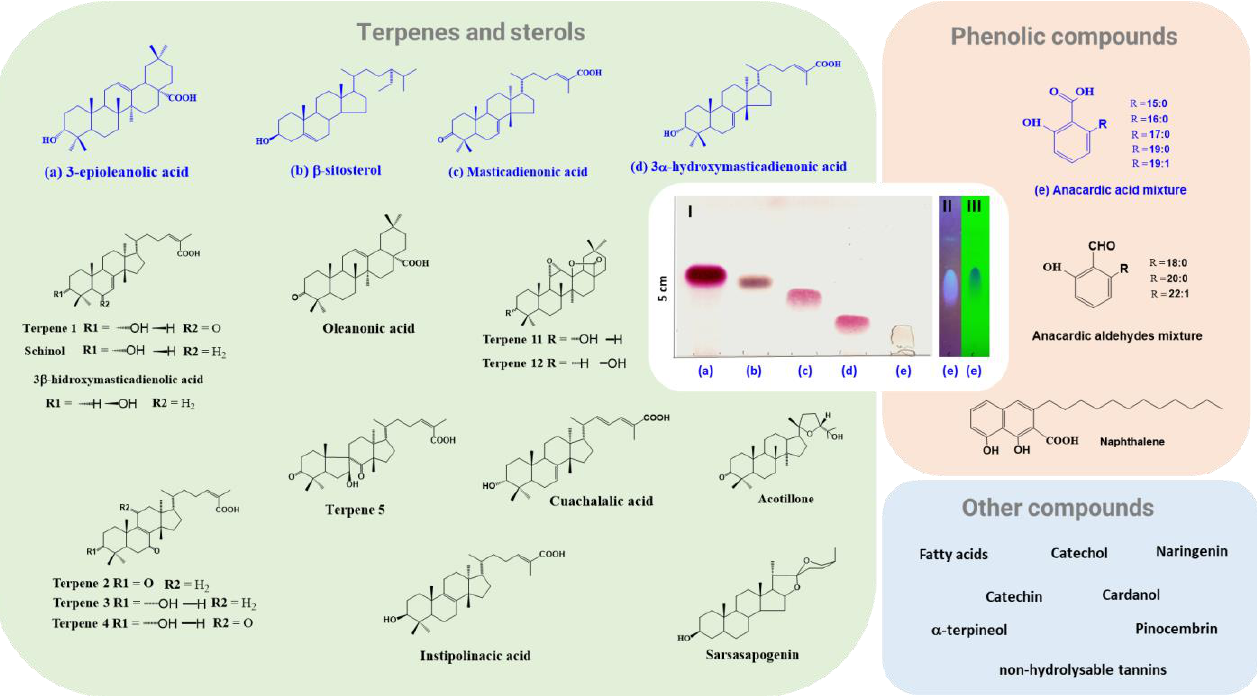
Figure 6. Phytochemicals identified in the stem bark of A. adstringens . The most abundant bioactive compounds in the extracts with organic solvents are indicated in blue. ( I ) Thin-layer chromatography (TLC) revealed 10% vanillin in sulfuric acid (hexane/ethyl acetate, 7:3). The TLC plate is stimulated with shortwave ( II ) and longwave ( III ) ultraviolet light, with which the anacardic acid mixture is visualized (hexane/ethyl acetate, 1:1). In the case of the “other compounds” quadrant, these have only been identified by employing HPLC, GC/MS, or qualitative assays. The chromatoplate was made with compounds isolated and characterized by our research group.